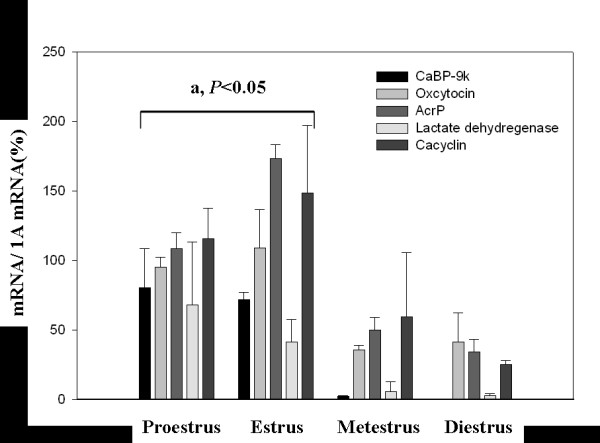
Expression of CaBP-9k, oxytocin, Acrp30, Ldha and calcyclin mRNAs in the uterus of adult rats during estrous cycle. To investigate the expression of these genes during estrous cycle, the expression levels of these genes in the uterus of adult female rats were analyzed by real-time PCR. Data were analyzed by non-parametric procedure of the Kruskal Wallis test, followed by Dunnett's test for two-pair comparisons. The values represent means ± SD. a, P < 0.05 vs. Metestrus and Diestrus.